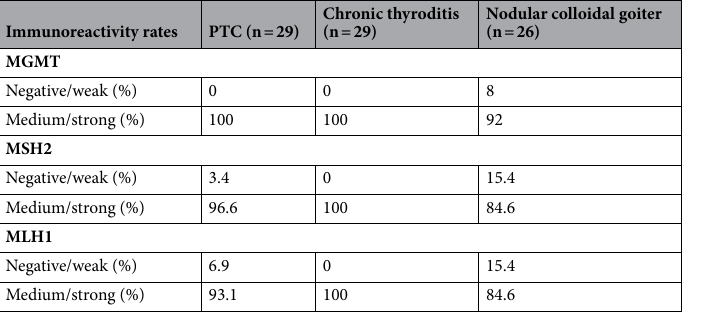
Immunoreactivity